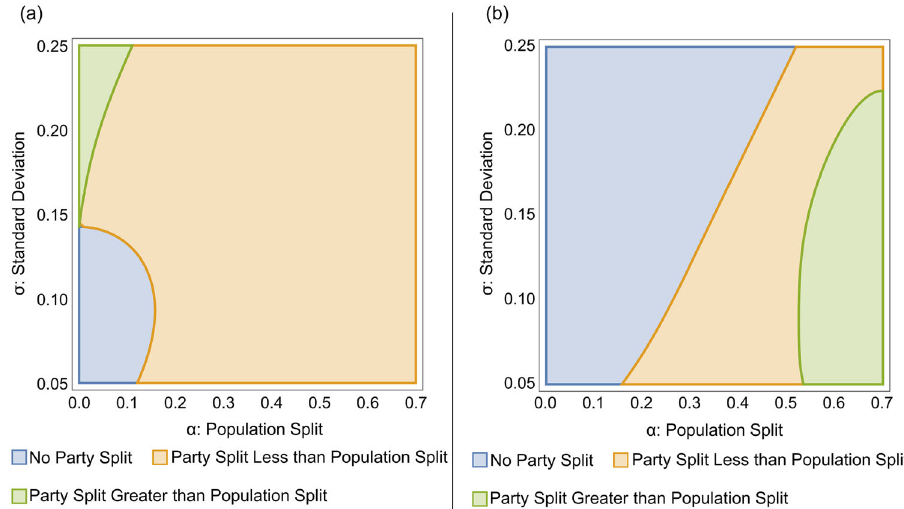
Fig. 6 For two sets of model parameters, the nature of the equilibrium candidate positions is shown as a function of the distribution of voter ideology. In both plots, the x -axis is population split and the y -axis is the standard deviation of the two subpopulations. a uses parameters P = 2, Q = 30, R = 1, and b uses P = 5, Q = 0, and R = 5. The three regimes of interest are whether candidates converge to the same position (roughly the mean/median voter theorem result), whether they separate to a lesser extent than the population (the space between the two peaks), or whether they separate to a greater extent than the population. Each space is shaded by adherence to one of these three regimes.